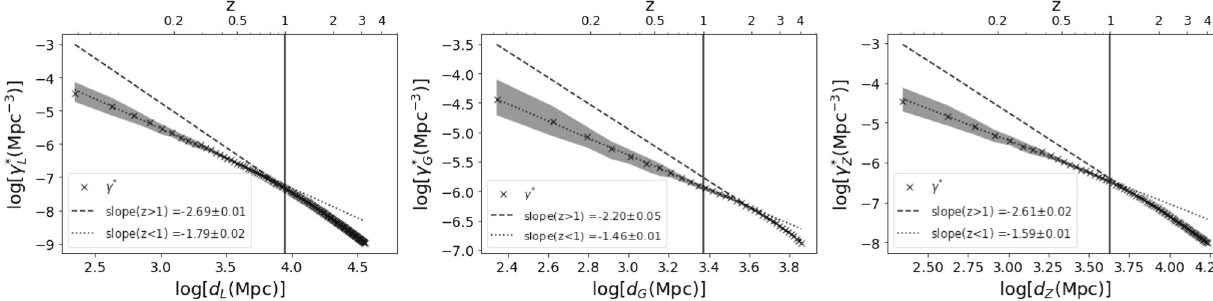
Fig. 12 Log–log graph of γ ∗ , γ ∗ and γ ∗ respectively vs. d L , d G and d z obtained with the blue COSMOS2015 star forming galaxy subsample in L G z the ranges z < 1 and 1 ≤ z ≤ 4 and respective distance measures. All results were obtained considering H 0 = 70 km/s/Mpc